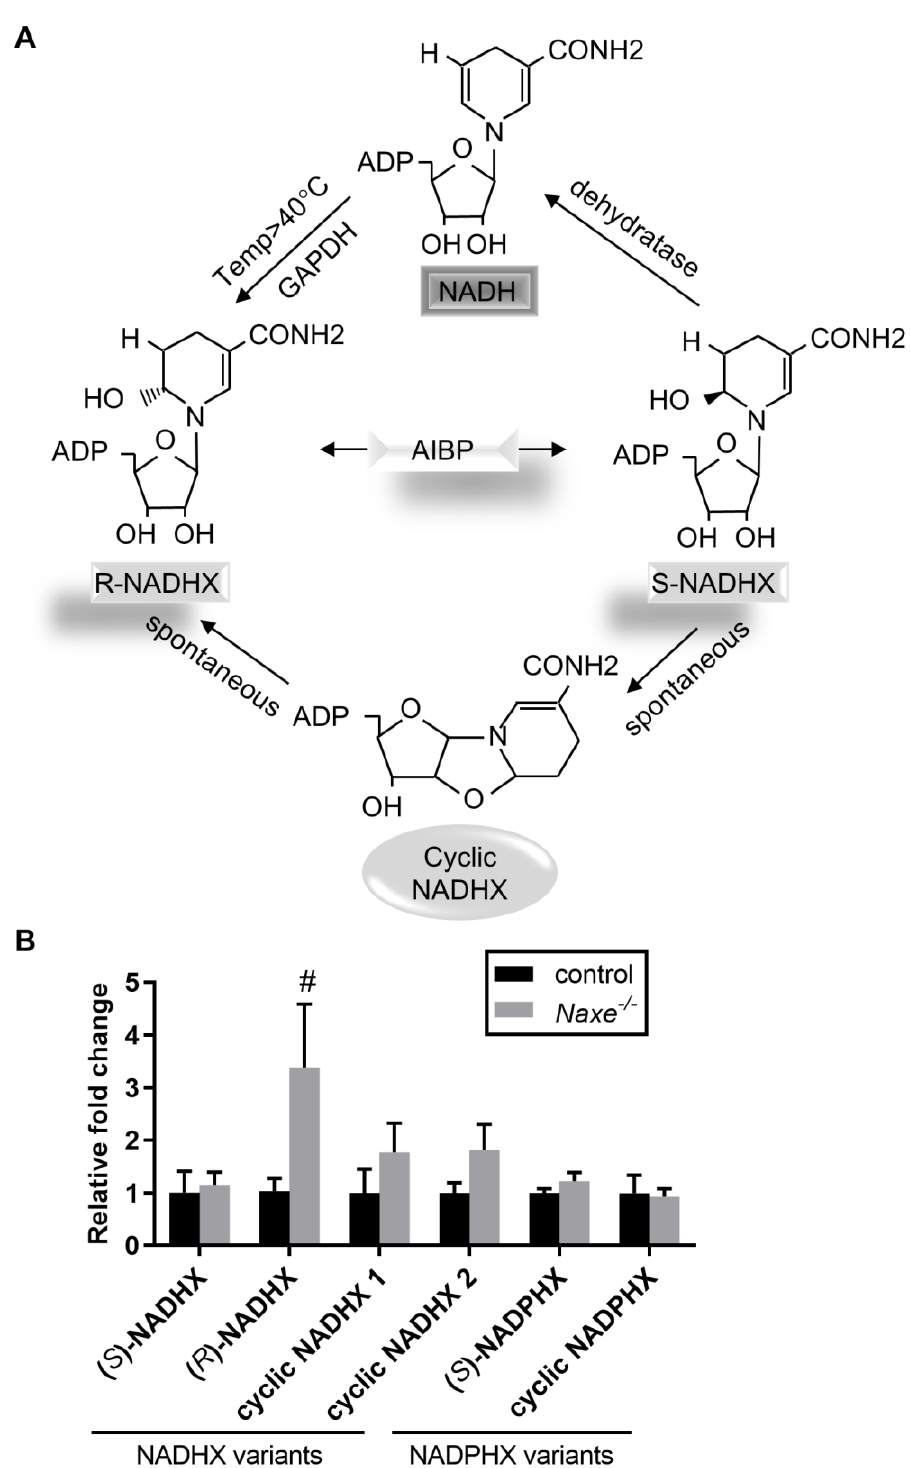
Figure 2. Effect of NAXE on NAD(P)HX content in cardiac tissue. ( A ) NAXE mediates the intercon- version of R- and S-NAD(P)X, which can either be repaired to normal NAD(P)H or become cyclic NAD(P)HX. ( B ) LC–MS-based measurements of distinct NAD(P)HX in control or NAXE knockout cardiac tissue. Mean±SE; # p = 0.087; n = 6 mice per group.